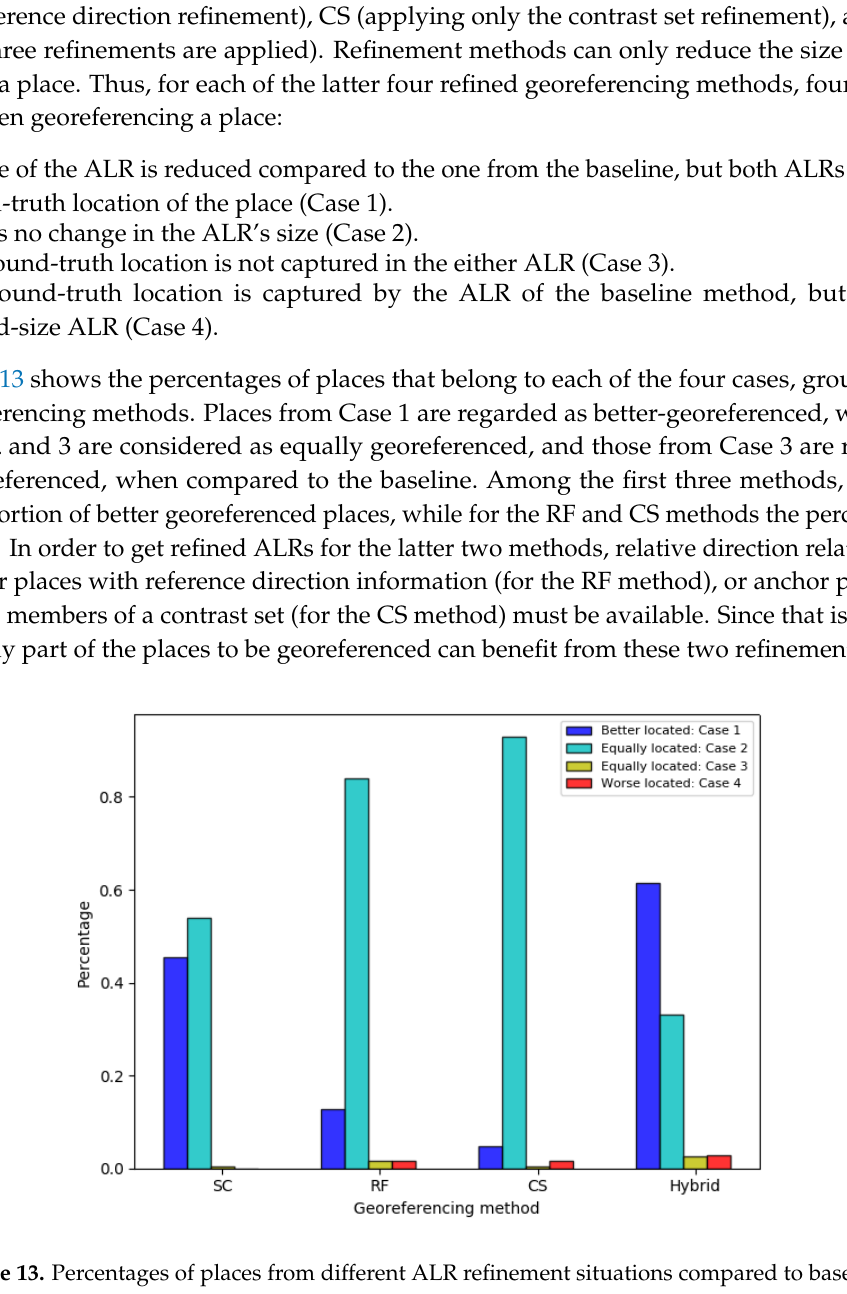
Figure 13. Percentages of places from different ALR refinement situations compared to